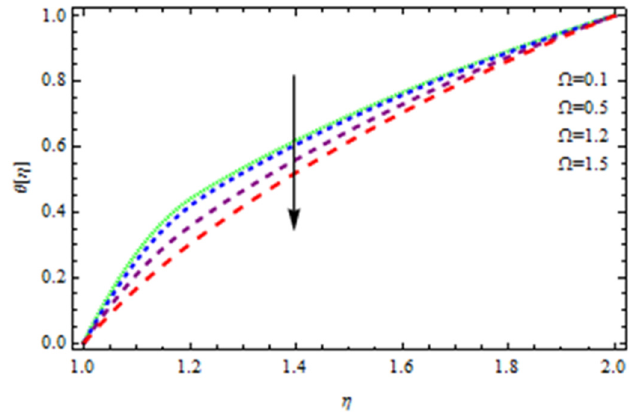
Figure 19. Temperature distribution in Vogel’s model for Ω .